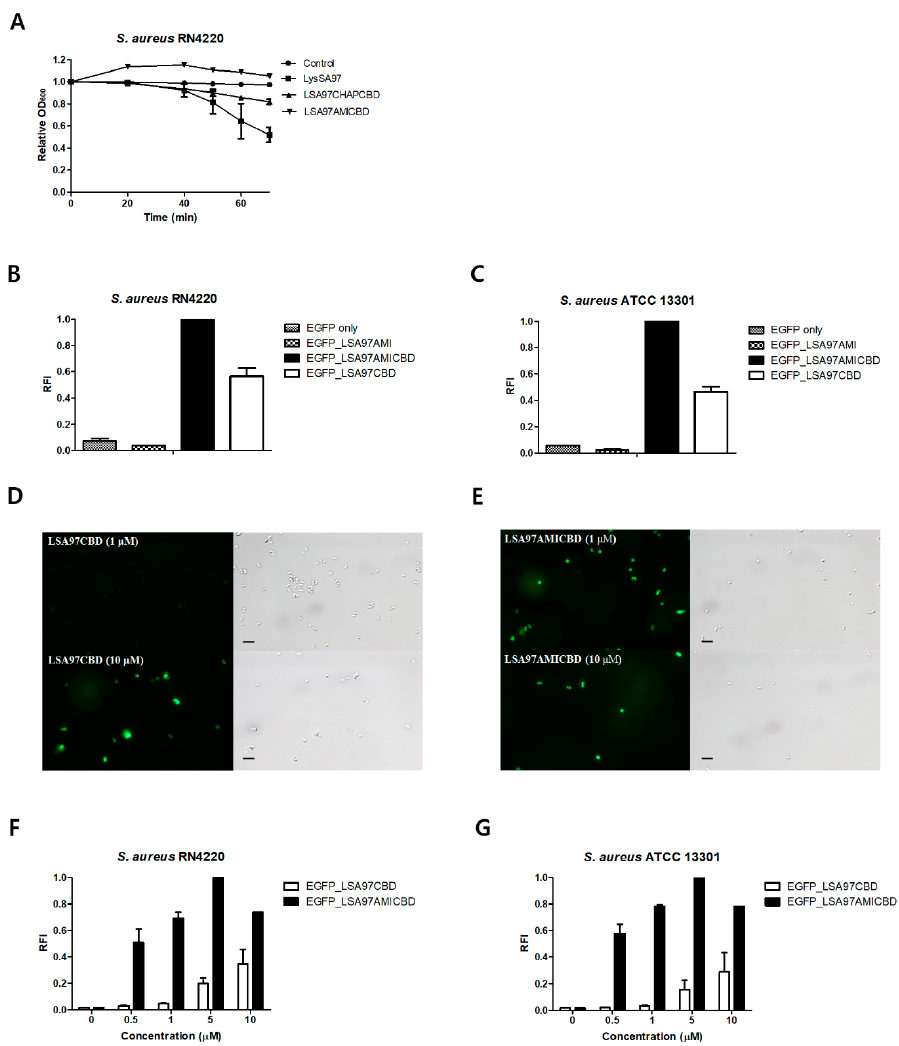
Figure 5. Determination of the role of the LysSA97 amidase domain. ( A ) Activity comparison of LysSA97 and LSA97CHAPCBD against S. aureus RN4220. Equimolar concentrations (2.0 μ M) of